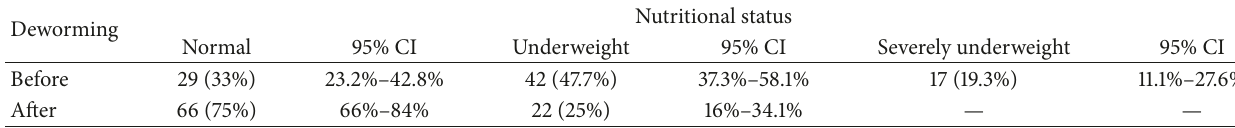
Table 5: The children nutritional status before and after